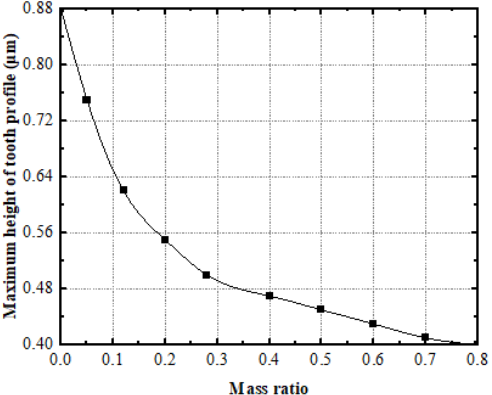
Figure 7. The effect of mass ratio on the greatest peak of face gears.